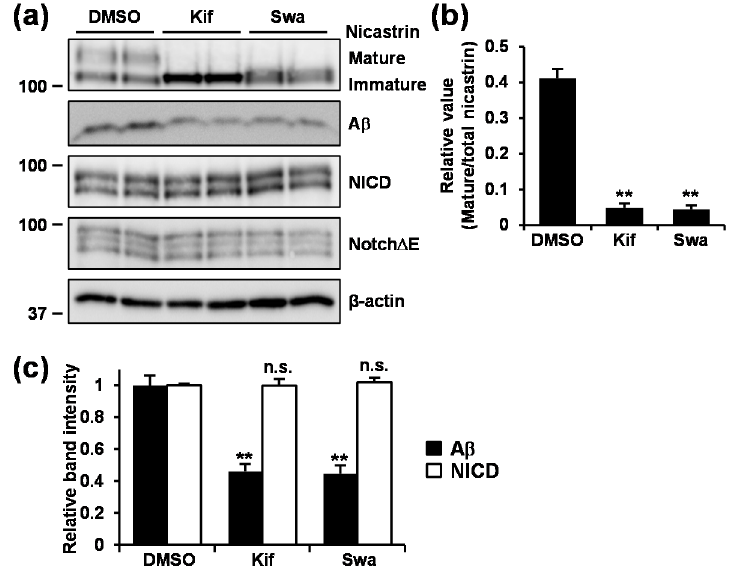
Figure 6. Effect of kifunensine or swainsonine treatment on A β and NICD production. ( a – d ) CHO-APP / Notch ∆ E cells were treated with 1 µ g / mL kifunensine (Kif) or 1 µ g / mL swainsonine (Swa) for 48 h. ( a ) Whole cell lysates were immunoblotted with appropriate antibodies as indicated. ( b – d ) Band intensities of nicastrin ( b ), and A β and NICD ( c ) were quantified by densitometric scanning, relative value being shown. Mean ± SD n = 3, ** p < 0.01, n.s. = not significant.